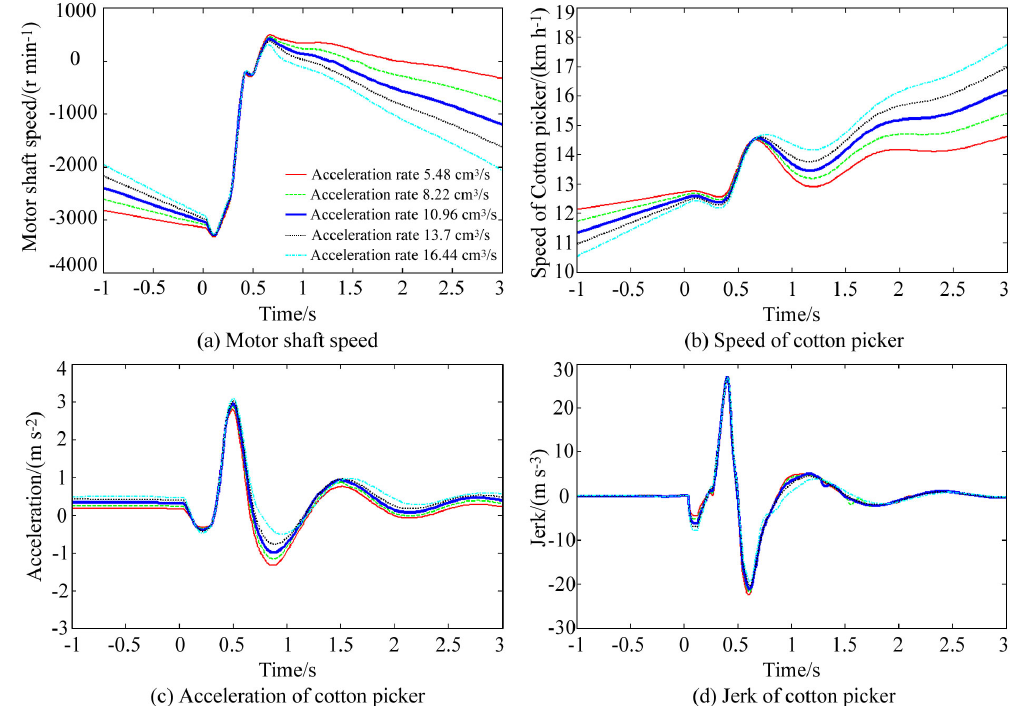
Figure 10. Influence of acceleration rate on the shift quality of the cotton